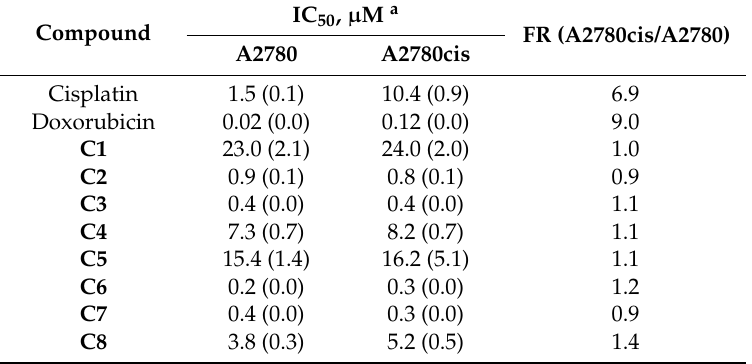
Table 2. Half-maximal inhibitory concentrations (IC 50 ) of reference drugs and gold (III) compounds in ovarian cancer cell line A2780 and its cisplatin- and doxorubicin-resistant A2780cis clone and fold resistance